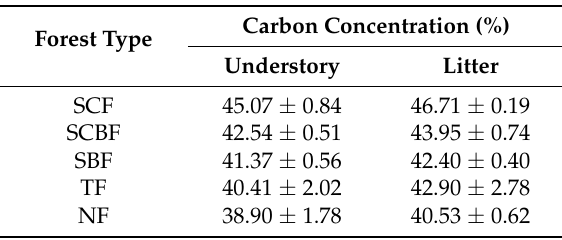
Table 3. Carbon concentration (mean ± SE) of understory vegetation and